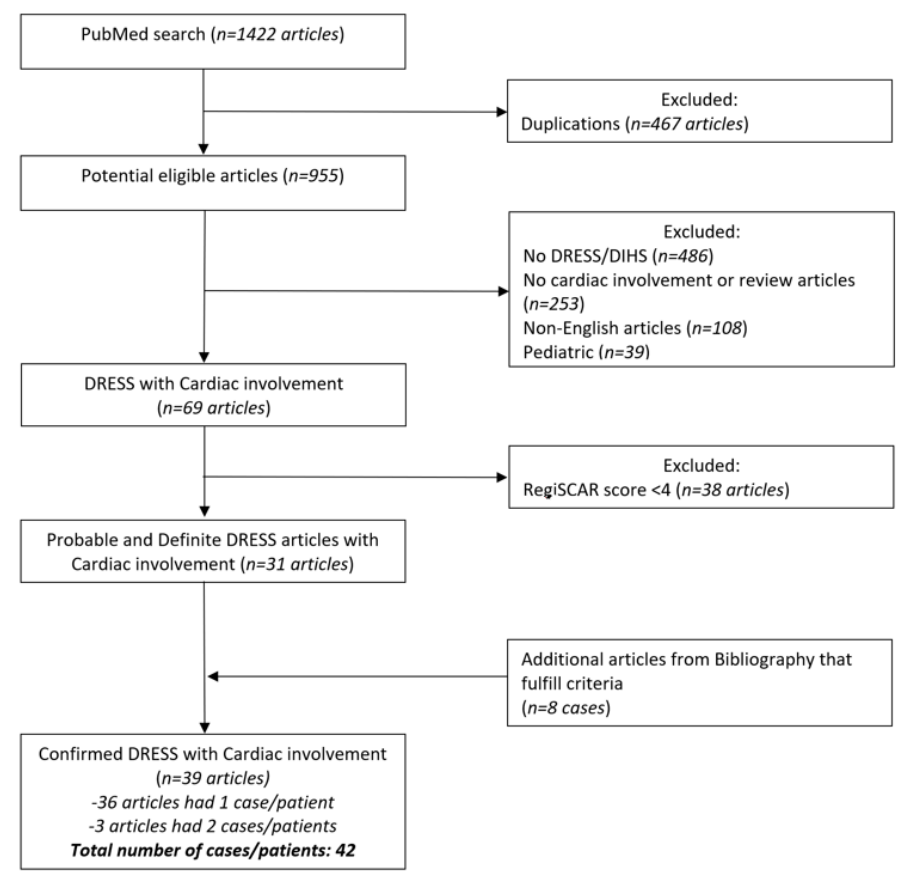
Figure 1. Figure one illustrates detailed flow chart of literature search according to PRISMA (Preferred Reporting Items for Systematic Reviews and Meta-Analyzes) guidelines.